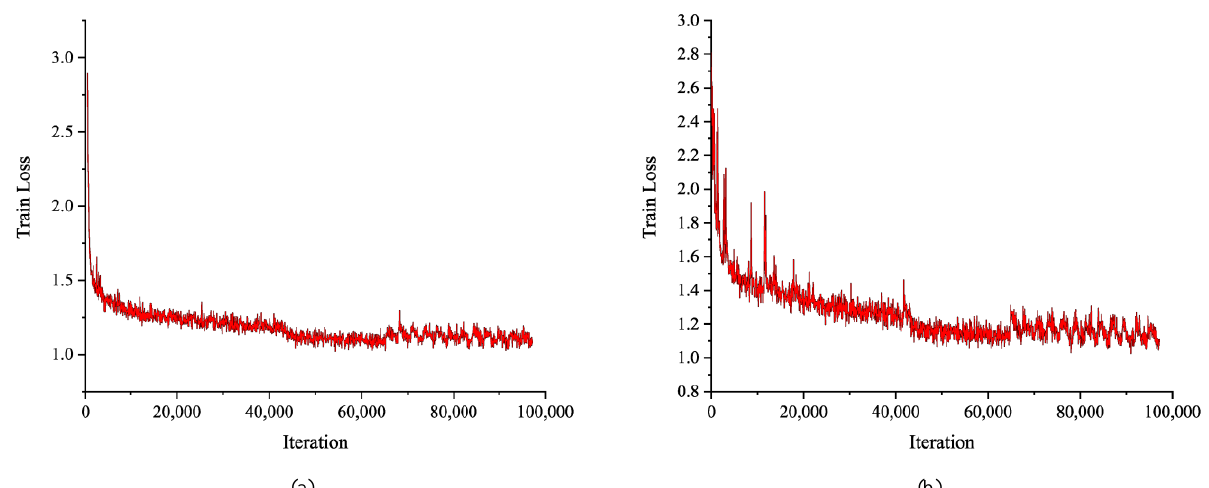
Figure 7. The evolution of the loss function in the training stage. ( a ) The evolution of the loss function on DIOR dataset. ( b ) The evolution of the loss function on DOTA v1.5 dataset. on DIOR dataset. ( b ) The evolution of the loss function on DOTA v1.5